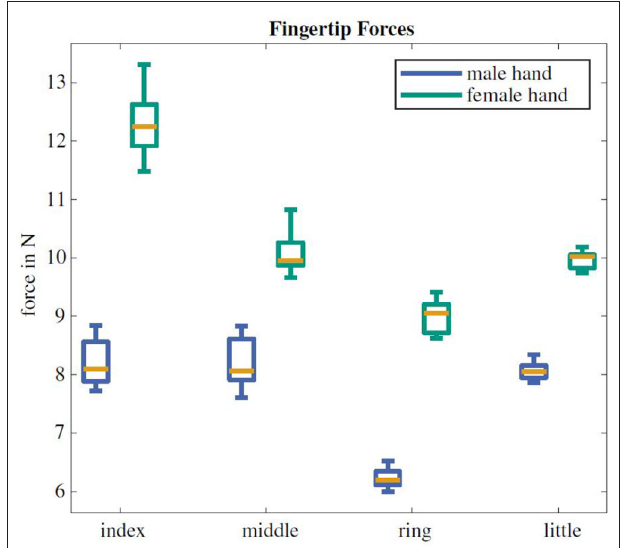
FIGURE 5 | Fingertip forces of the male and female prosthesis. The orange line marks the median force, the box boundaries denote the first and third quartile and the outer lines depict the extrema of the respective fingertip force.